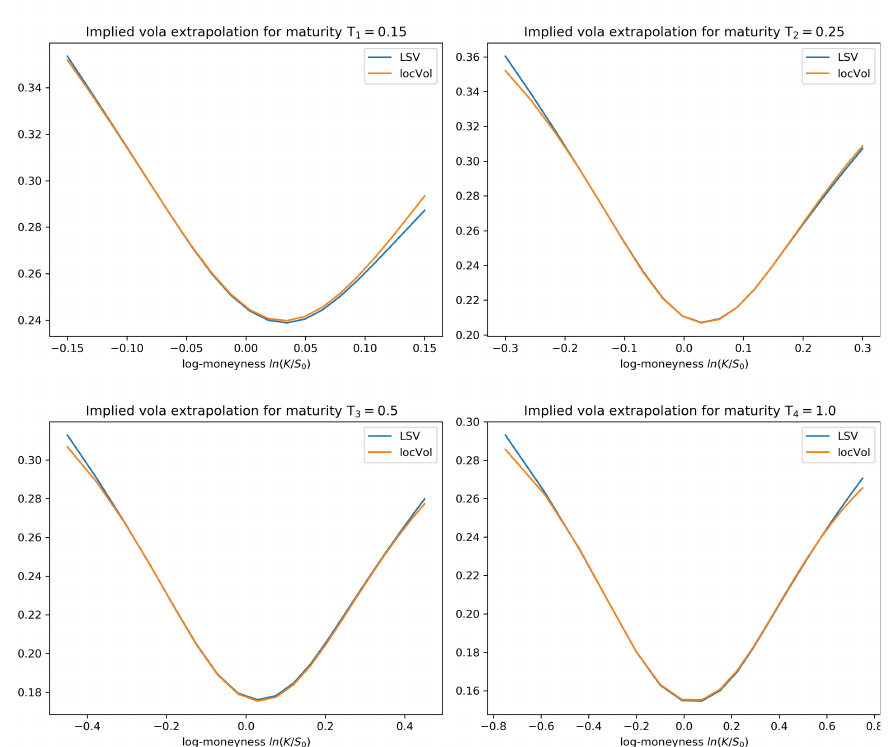
Figure 6. Extra- and interpolation as described in Section 4.2 between the synthetic prices of the ground truth assumption against the corresponding calibrated SABR-LSV model. Plots are shown for all four considered maturities { T 1 , . . . , T 4 } as defined in Figure 2a. The x -axis is given in log-moneyness ln ( K / S 0 ) .